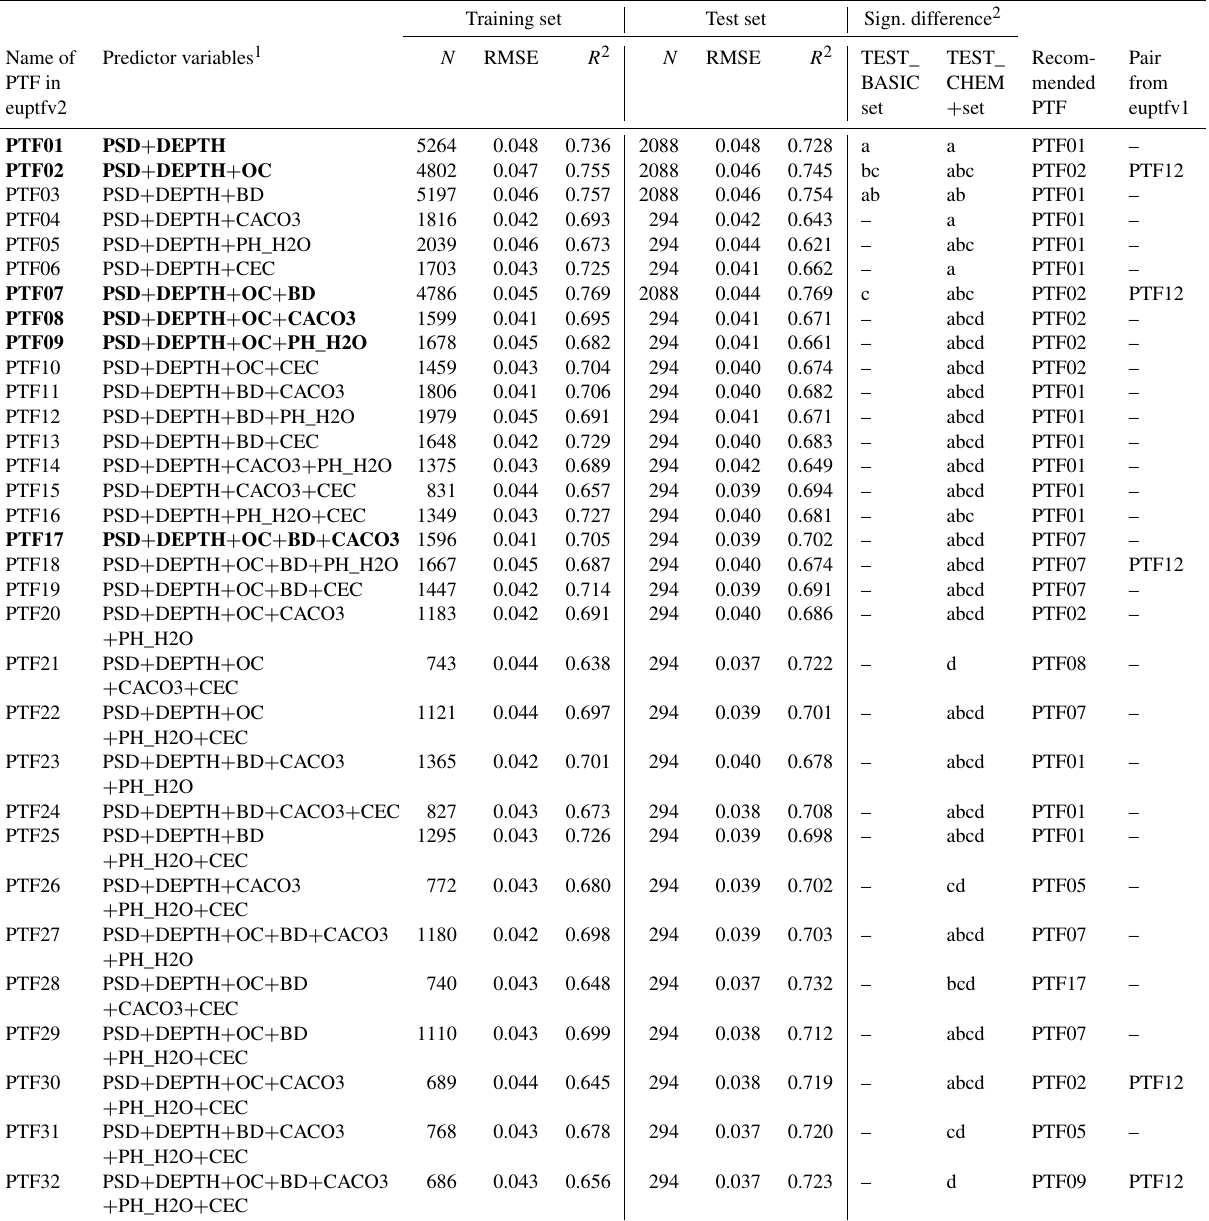
Table 5. Performance of pedotransfer functions (PTFs) by input combination on training and test datasets to predict water content at wilting point (WP). N : number of samples, RMSE: root mean square error (cm 3 cm − 3 ), and R 2 : determination coefficient, TEST_BASIC: samples with measured PSD, DEPTH, OC and BD; TEST_CHEM + : samples with measured PSD, DEPTH, OC, BD, CACO3, PH_H2O and CEC. Recommended PTFs are highlighted in